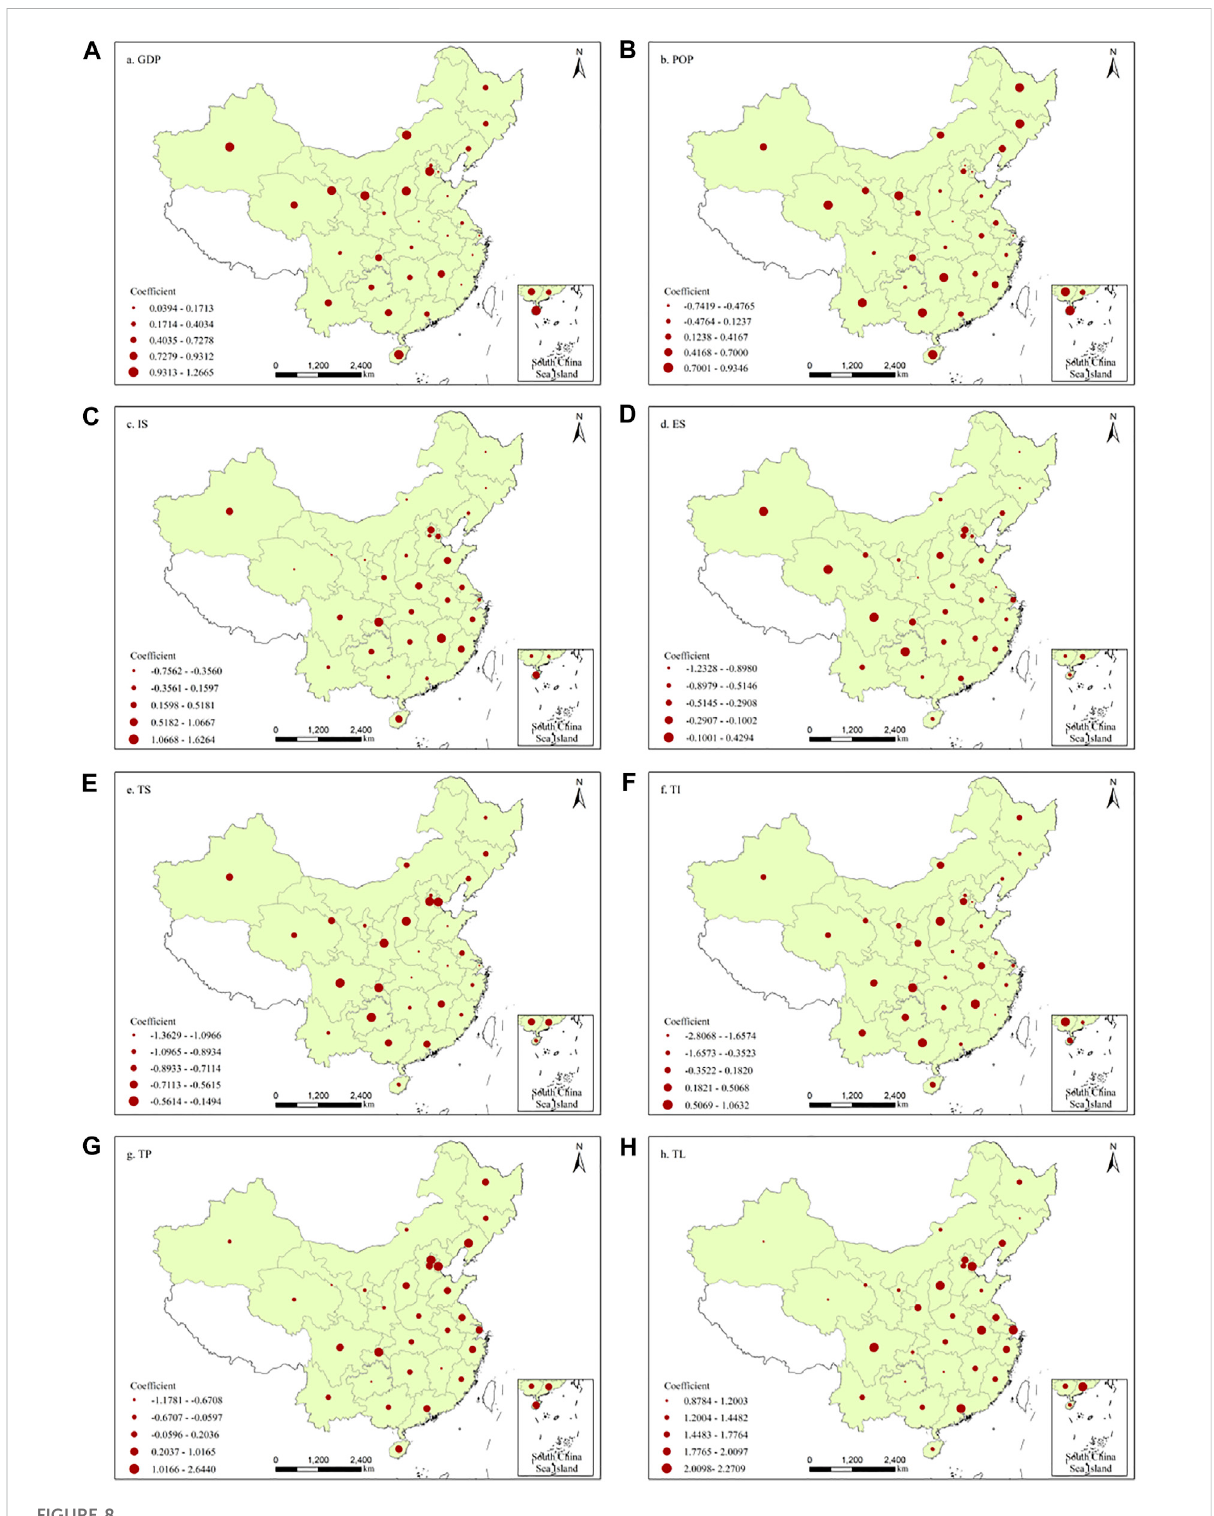
FIGURE 8 Spatial distribution characteristics of the coef fi cients for the in fl uencing